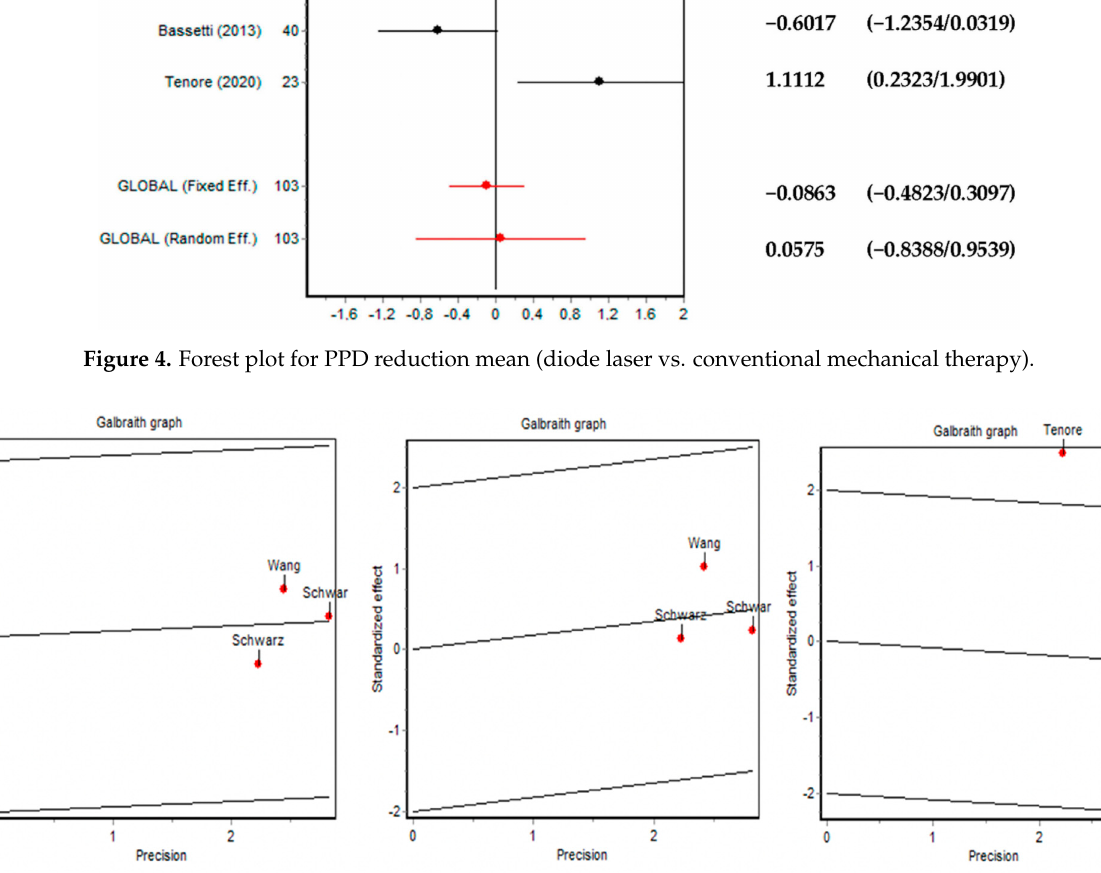
Figure 7. Funnel plot to show the risk of bias in the analyzed study: ( a ) CAL gain in Er:YAG laser group ( p = 1.0000), ( b ) PPD reduction in Er:YAG laser group ( p = 1.0000) and ( c ) PPD reduction in diode laser group ( p = 1.0000).